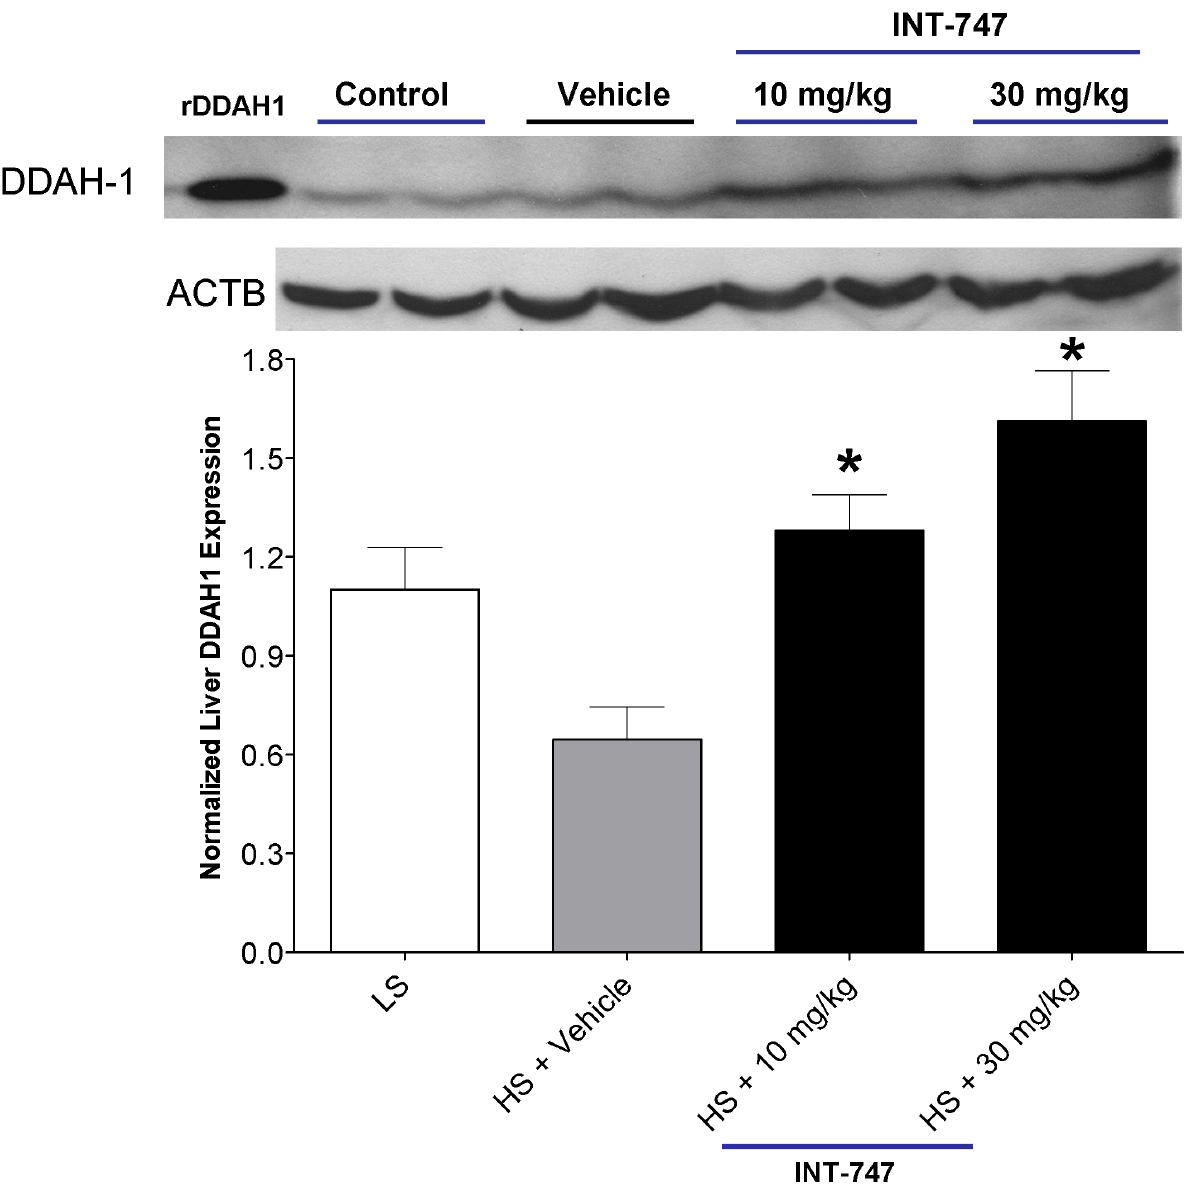
Figure 4. The effect of INT-747 treatment on DDAH1 expression in Liver. Animals were fed low (control)- or high-salt diet and treated with vehicle or INT-747 at 10 or 30 mg/kg/day for 6 weeks. Liver lysates were compared for DDAH1 expression by Western blot. rDDAH1: purified recombinant human DDAH1 described previously [53]. The DDAH1 expression was normalized to b -Actin (ACTB). DDAH=dimethylarginine dimethylaminohydrolase. Data is expressed as Mean 6 SEM. (*p , 0.05 versus control value. ANOVA followed by Bonferroni